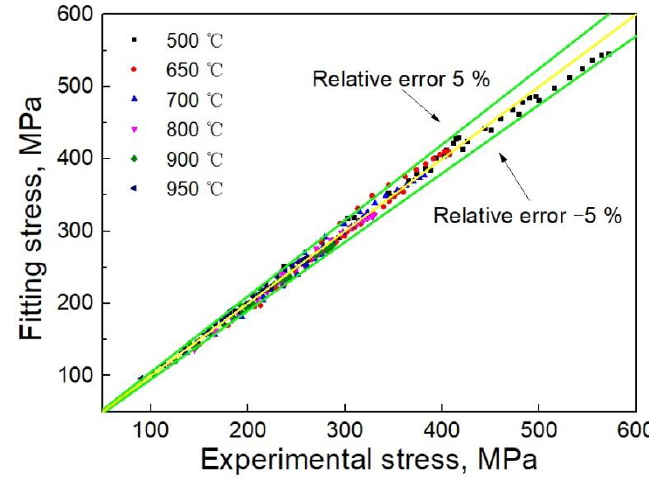
Figure 17. Correlation between experimental values and constitutive fitting values.